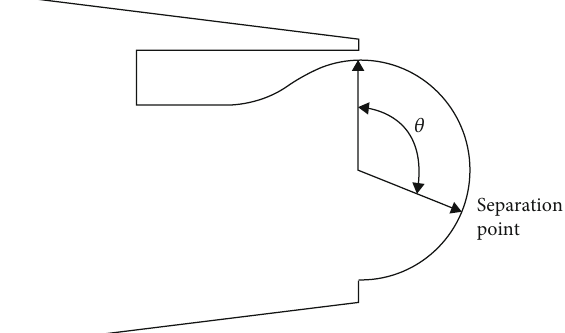
Figure 28: De fi nition of separation angle for upper slot blowing.